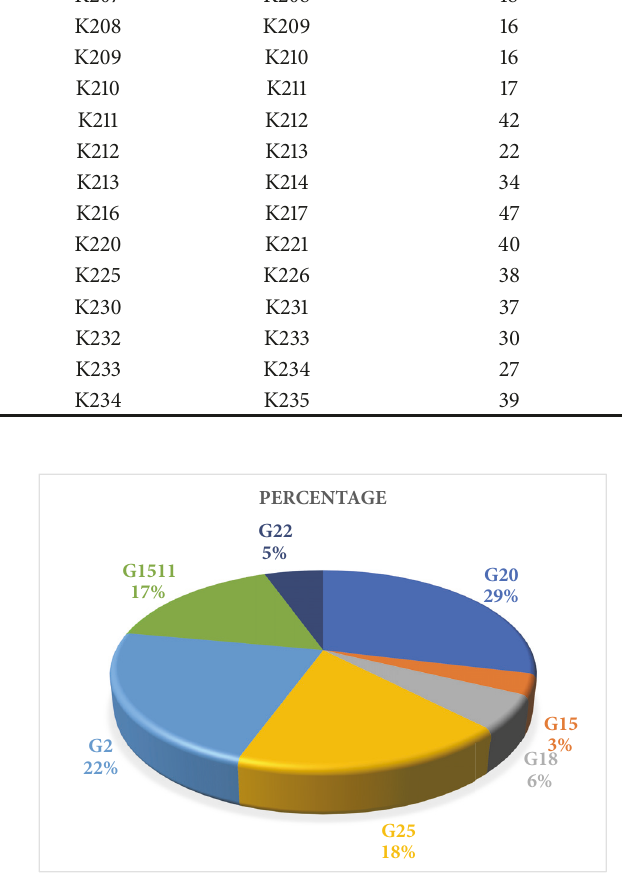
Figure 3: The percentage of accidents on every